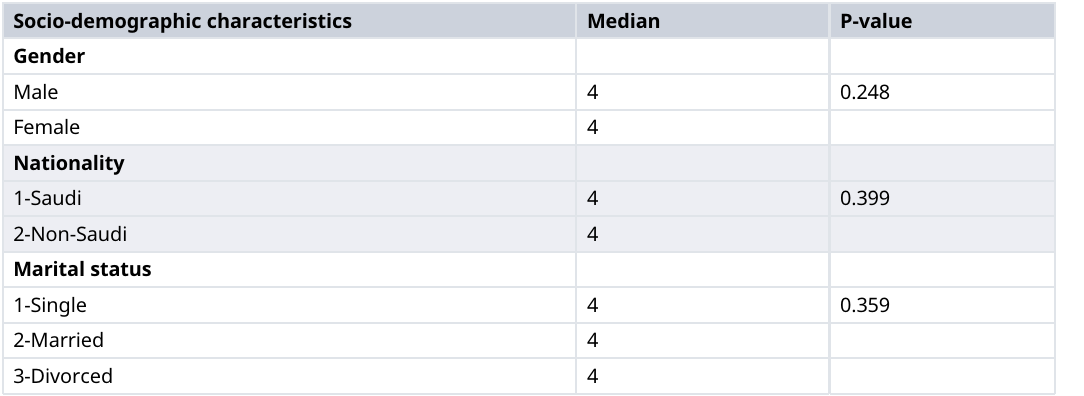
Table 3. Association of knowledge with socio-demographics of dental auxiliaries